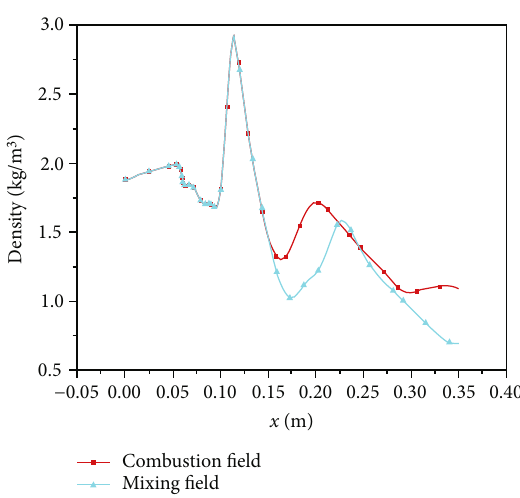
Figure 20: The density distribution at the axis of y = 0mm and z = 50mm